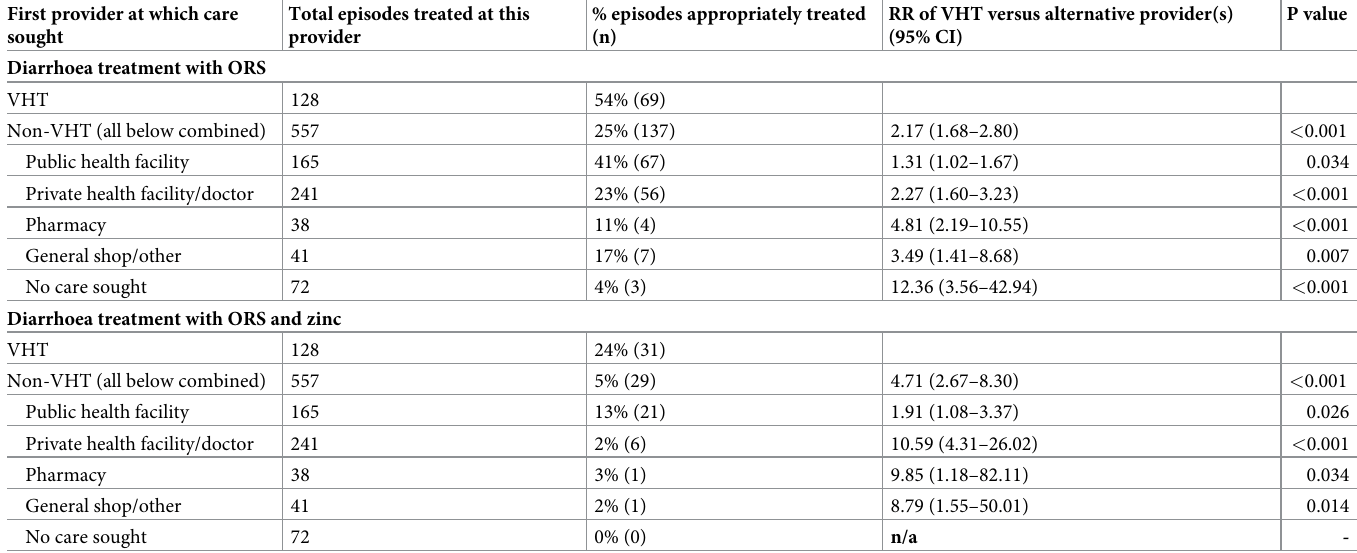
Table 7. Appropriate treatment of children with diarrhoea with ORS or ORS plus zinc by first provider where care was sought. Significance tests compare appropri- ate treatment rate at the VHT (‘exposure group’) versus other provider types (‘null group’) in turn. First provider at which care sought